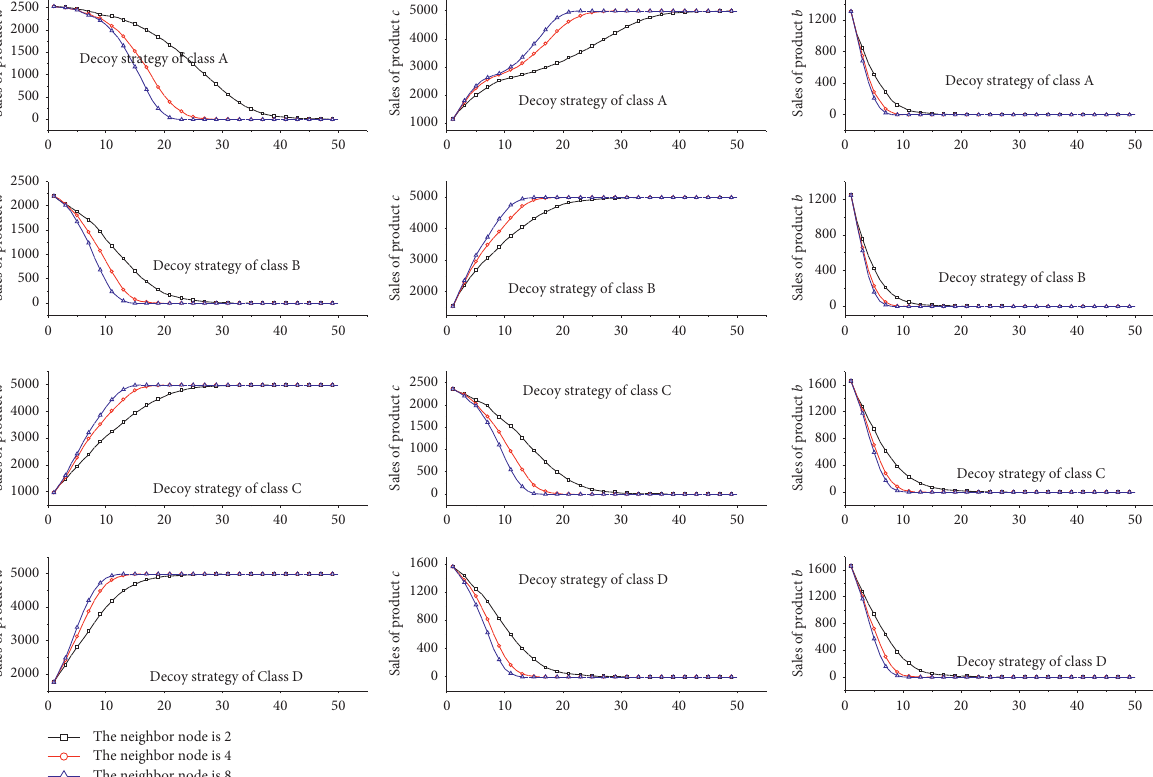
Figure 6: Evolution trends for sales of products a , c , and b under the four kinds of true decoy strategies in scenarios with different neighbor node